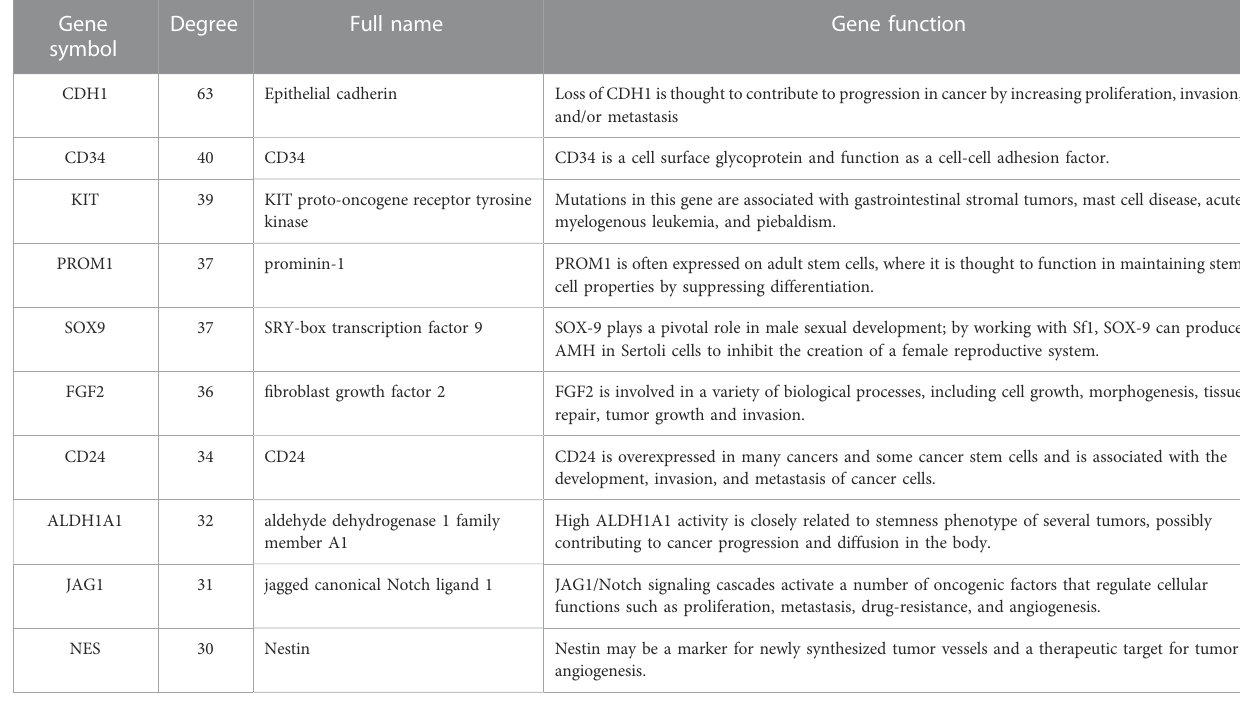
TABLE 2 Details of hub